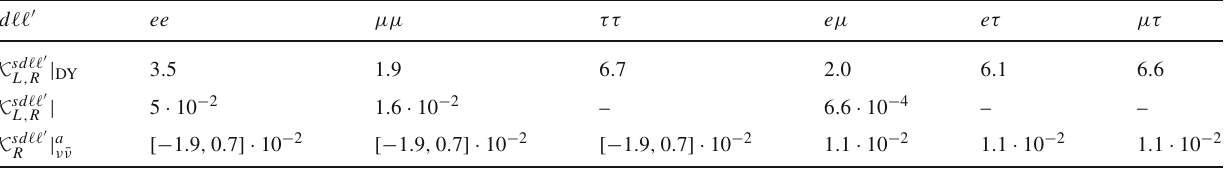
from high– a limit on the modulus. LFV-bounds are quoted as flavor-summed, (cid:9) A | K (cid:4) + (cid:4) (cid:2)− | 2 + | K (cid:4) − (cid:4) (cid:2)+ | 2 . a Obtained assuming no large cancellations between K sd and K cu R L